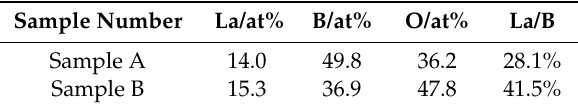
Table 2. The atomic percentage of each element for the LaB x thin films deposited under different working pressure. (Sample A: a 300-nm LaB x was prepared on silicon substrate by magnetron sputtering with a working pressure of 0.25 Pa. Sample B: a 300-nm LaB x was prepared on silicon substrate by magnetron sputtering with a working pressure of 3.8 Pa).